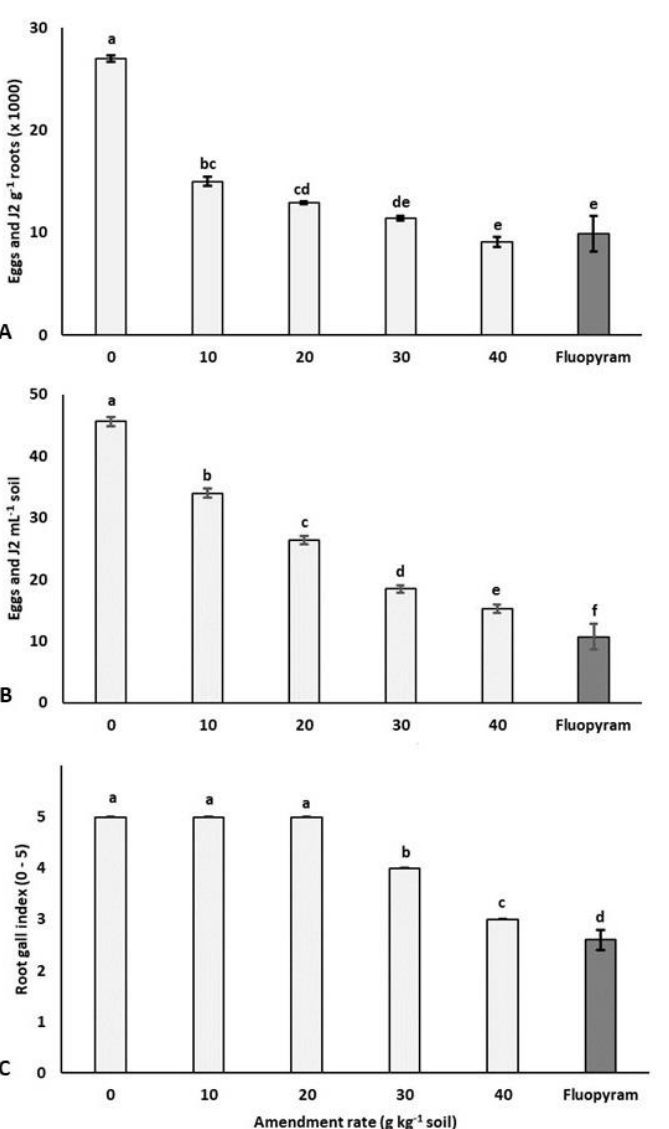
Figure 2. Effect of soil amendments with 10 – 40 g kg − 1 soil rates of dry biomass of Hedysarum coronarium and Fluopyram (0.625 L ha − 1 ) on the multiplication of Melodogyne incognita on tomato roots ( A ), in soil ( B ), and on root gall formation ( C ). The values are averages of five replicates. Bars marked with the same letter are not significantly different according to the LSD test ( P < 0.05).